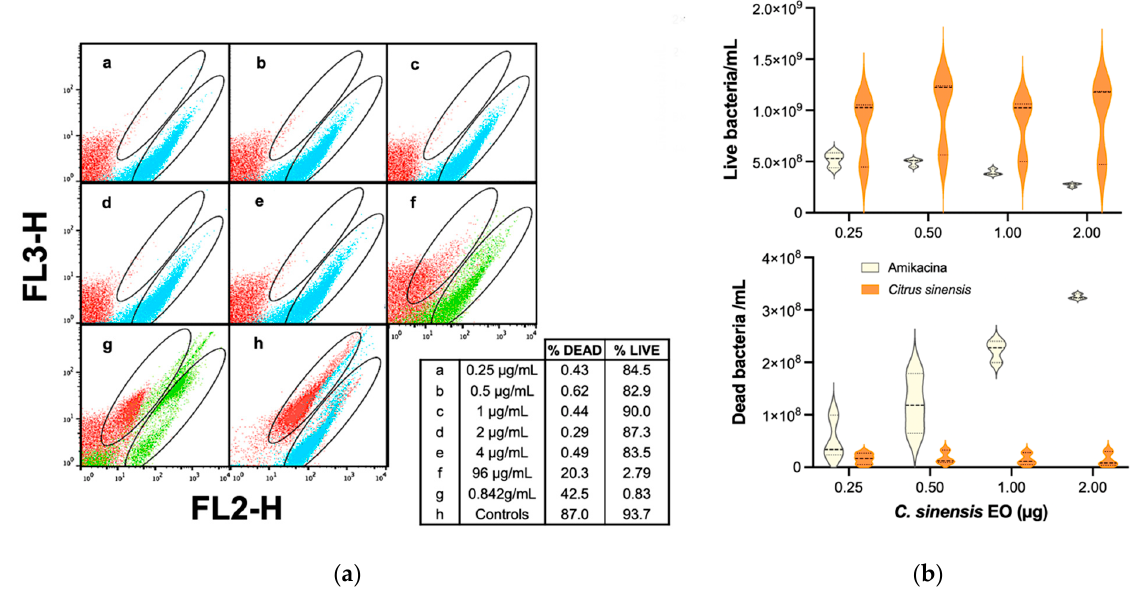
Figure 7. Evaluation of the antibacterial activity of C. sinensis EO. ( a ) Dot plot of green (FL3-H) vs. red (FL2-H) fluorescence gates for several concentrations of C. sinensis oil; ( b ) Violin graphs of the quantization of cell numbers in some of the used concentrations. Student’s t -test: p = 0.003 and p = 0.001 for live and dead bacteria, respectively.